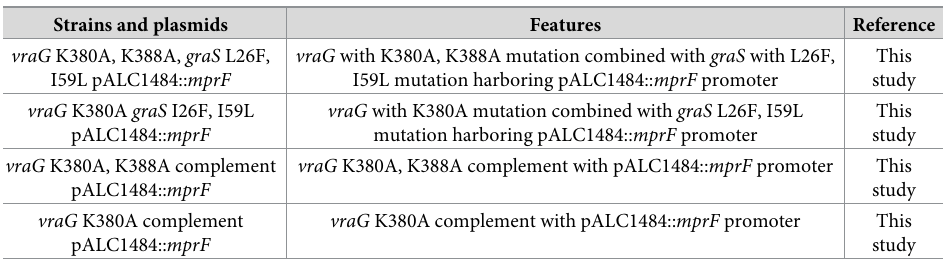
Table 2. MIC of PMB for vraG mutants in CF32A1.